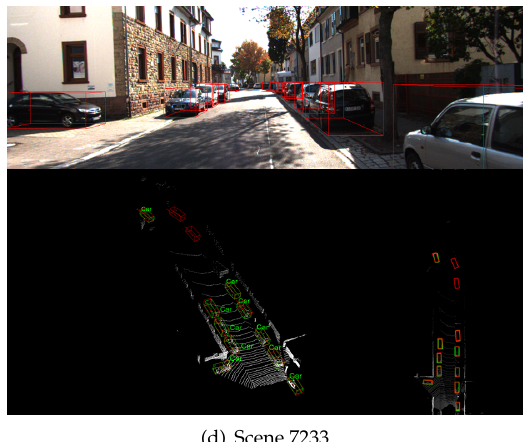
Figure 8. Detection results on the KITTI validation set, where the green boxes represent the bounding boxes of the ground truth, the red boxes represent our detection results, and the short red lines indicate the results of our direction